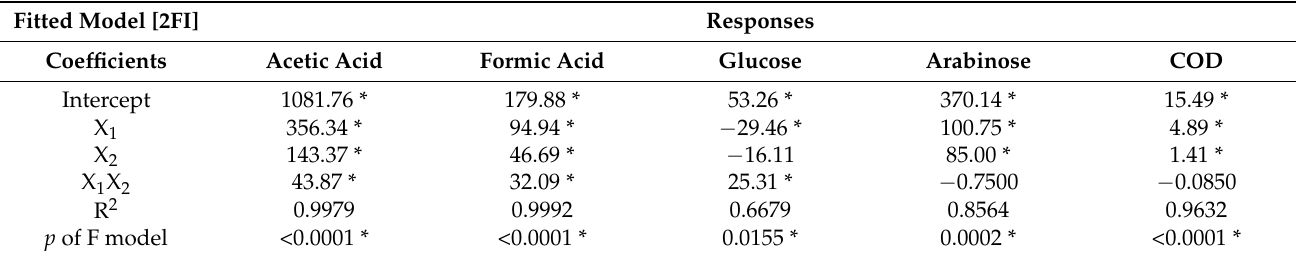
Table 3. Coefficients estimated by multiple linear regression of the physicochemical characterization of process water samples of wheat straw considering acids, sugars and